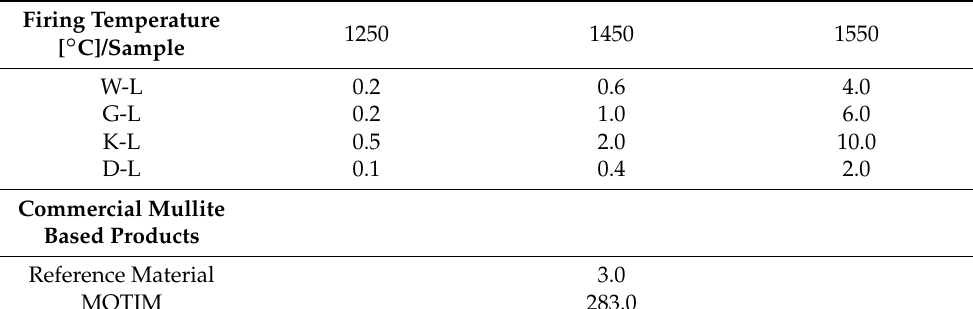
Figure 5. Comparison of mullite crystals size in matrices of K and G samples after two cycles of industrial firing with the reference material (firing temperature 1480 °C/5h soaking). Table 6. Mean size of mullite crystals [ μ m] on matrix of laboratory-produced samples, MOTIM mullite and reference material based on SEM observation.